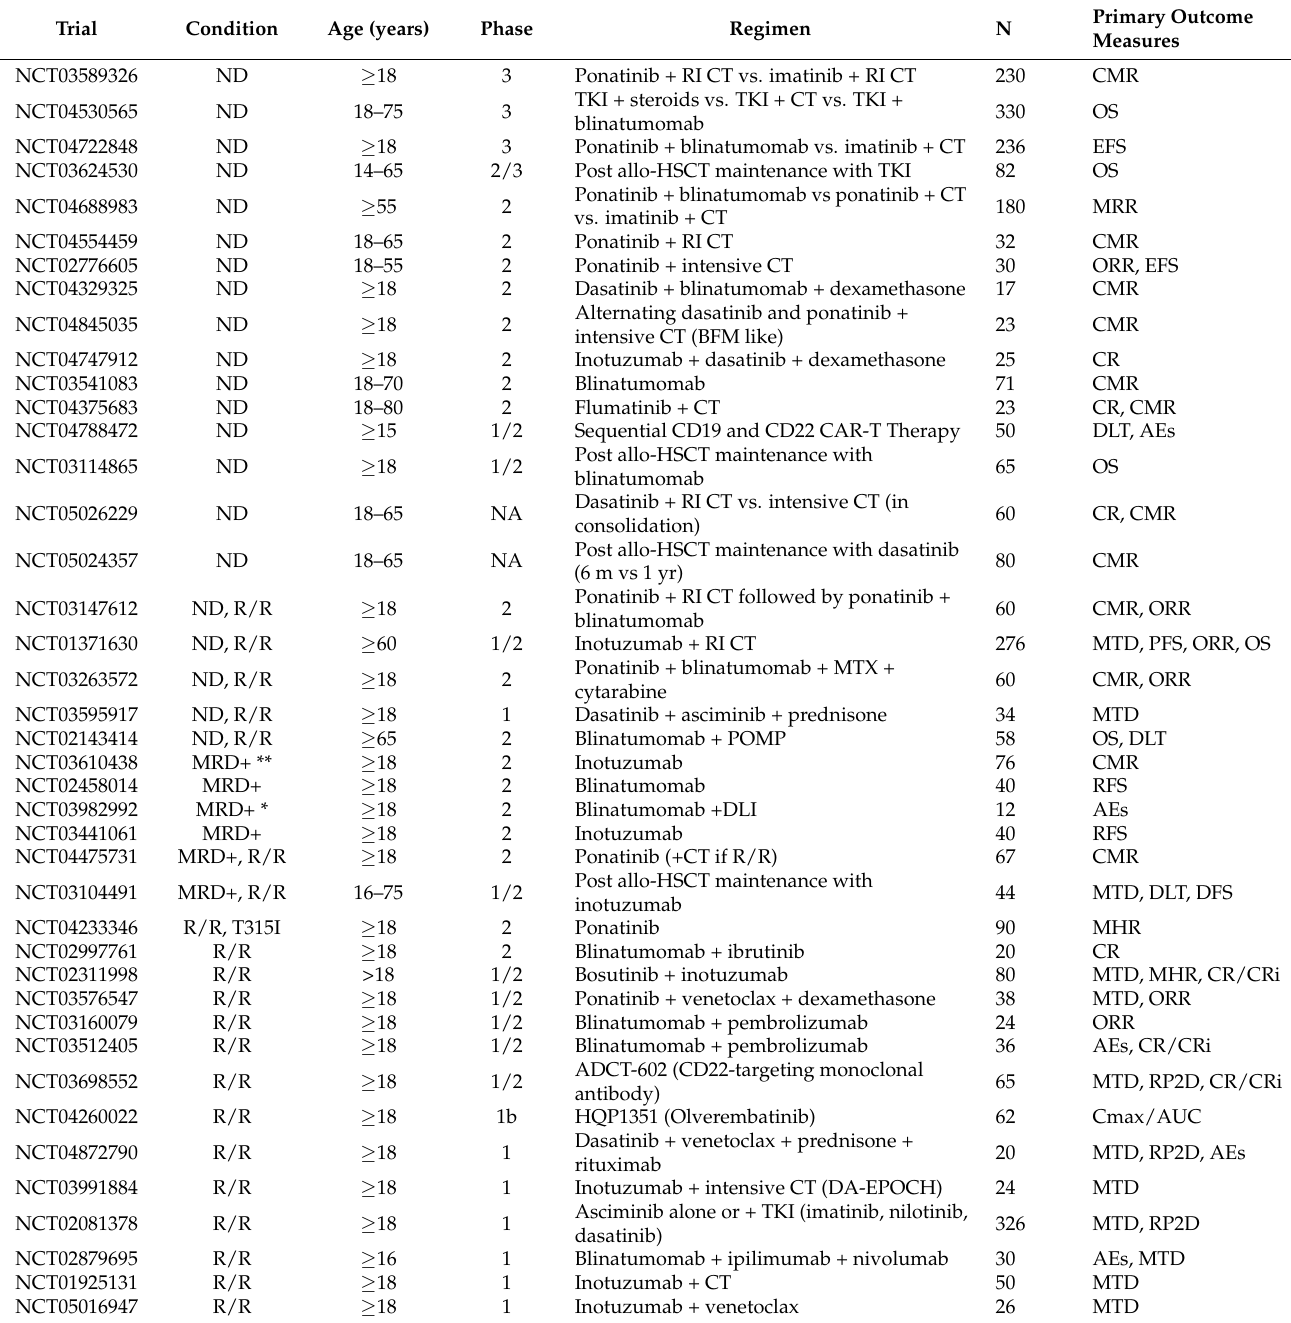
Table 2. Ongoing trials for adult Ph+ ALL